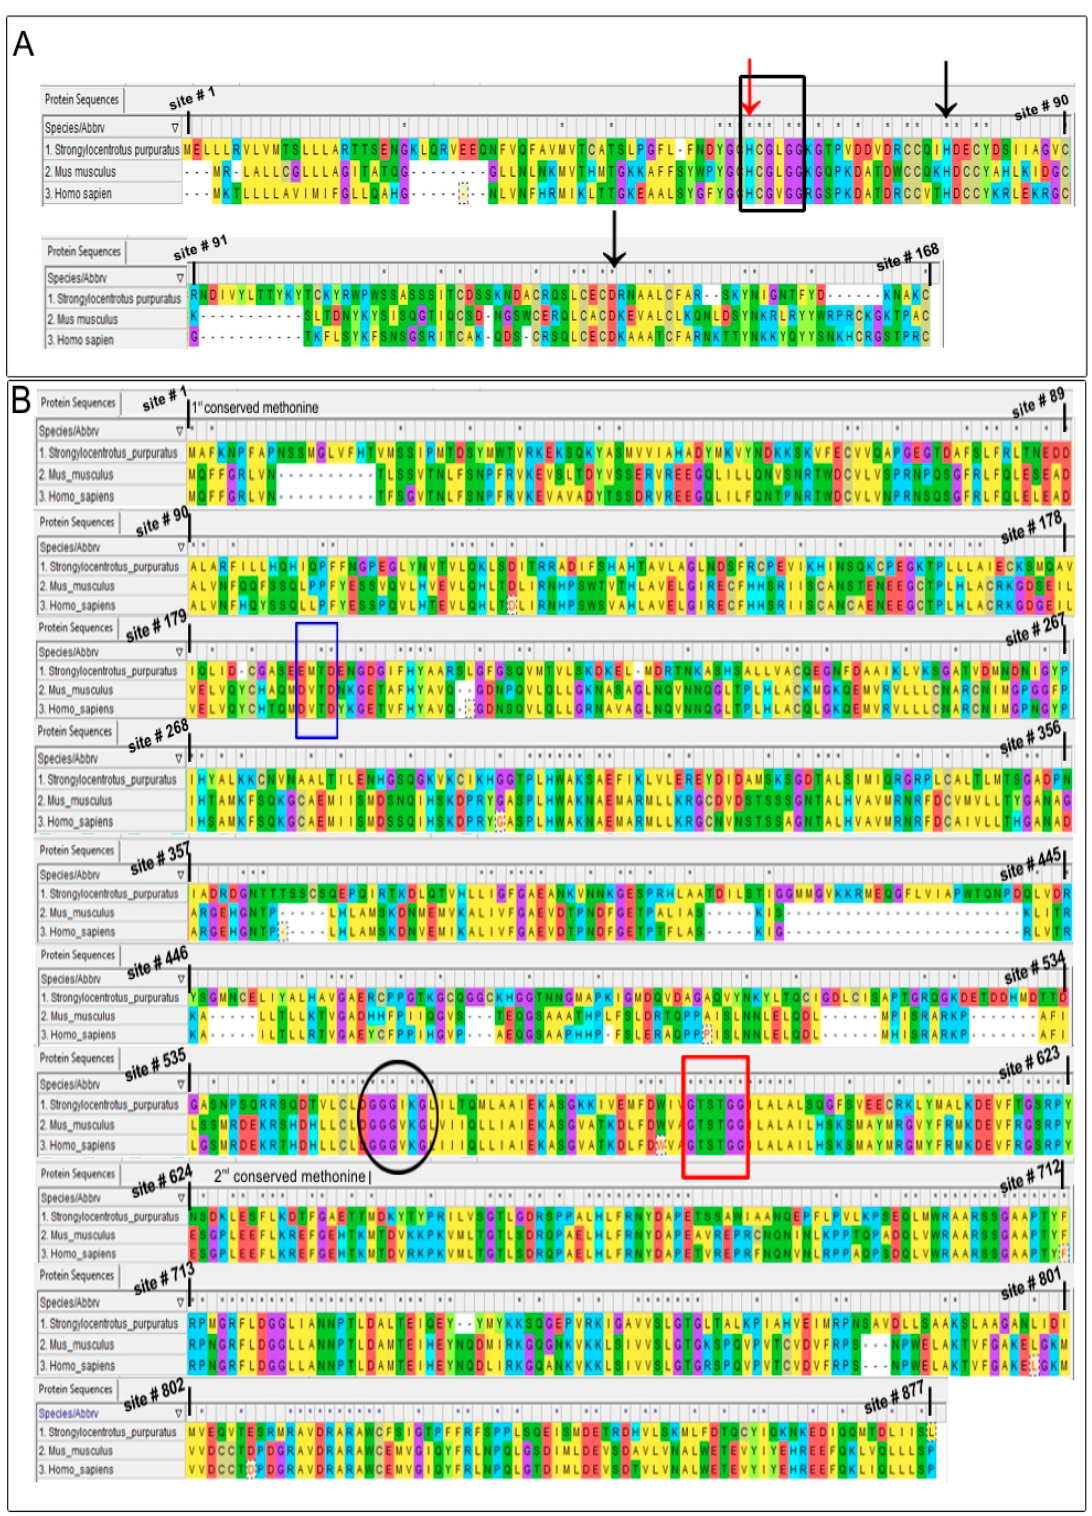
Figure 3. Sequence alignment of predicted urchin ( A ) sPLA 2 and ( B ) 80–85 kDa iPLA 2 . The first row in each panel is the amino acid sequence of urchin PLA 2 isozymes and the subsequent two rows are of murine and human PLA 2 isozymes, respectively. Conserved amino acids are indicated with an asterisk and site # represents the amino acid residue number in the primary urchin PLA 2 sequence (also considering gaps). The red arrow indicates conserved Histidine in the Ca 2+ binding loop (Black box), the site at which LY311727 binds. Black arrows show conserved Histidine and Aspartic acid which form the